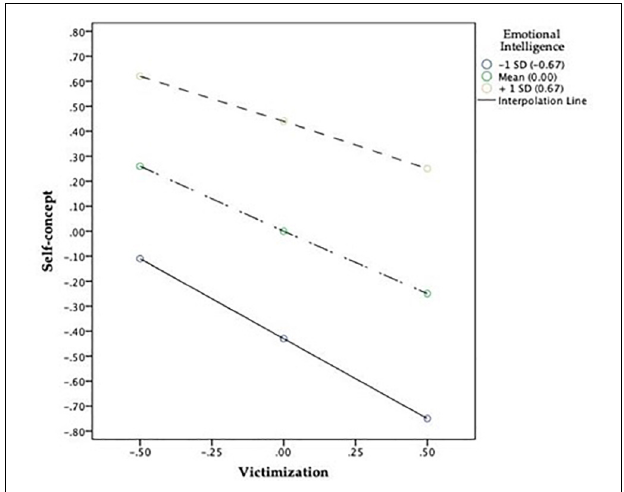
FIGURE 2 | Influence of the different EI levels on the relationship between victimization and self-concept. SD, standard deviation; M,